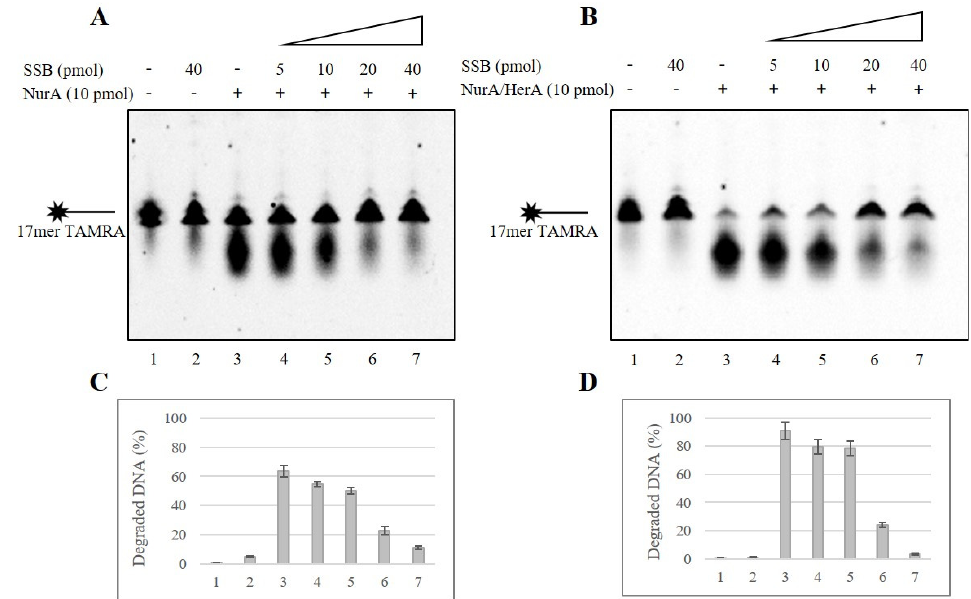
Figure 2. Effect of SSB on NurA and NurA/HerA exonuclease activity on 17 mer ssDNA substrate. ( A ) NurA exonuclease activity was tested on a 17 mer 5 ′ -TAMRA ssDNA in absence (lane 3) or presence (lanes 4–7) of increasing amounts of SSB. Negative controls were performed in absence of proteins (lane 1) and in the presence of the maximum amount (40 pmol) of SSB alone (lane 2). ( B ) The same experiment was performed using 10 pmoles of NurA/HerA complex instead of NurA. ( C , D ) The gels were quantified as reported in the Materials and Methods, and the values were average of three different experiments and reported here.